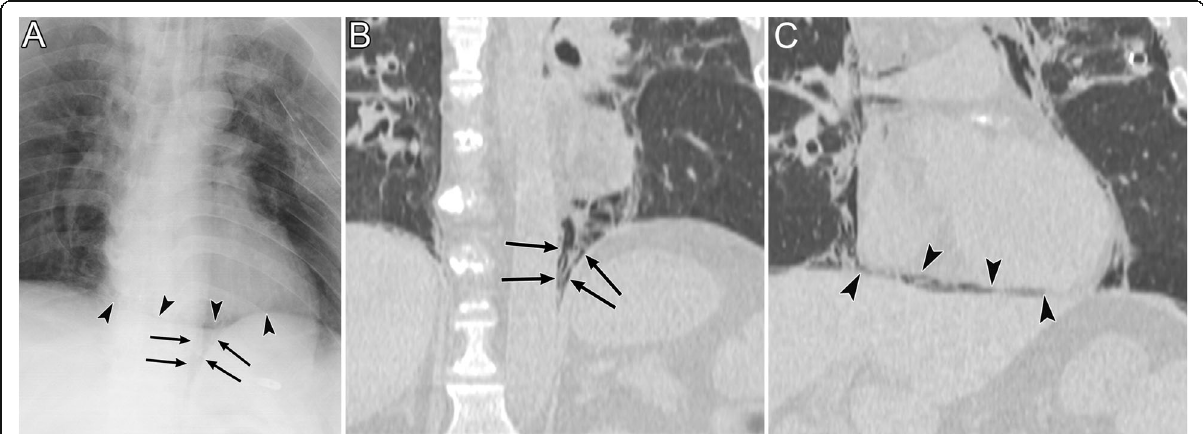
Fig. 16 Pneumomediastinum in a 50-year-old man. The pneumomediastinum was caused by tracheostomy displacement. a A supine radiograph shows pneumomediastinum and subcutaneous emphysema. Air along the left aortic border and the medial left hemidiaphragm become V- shaped (i.e., “ Naclerio ’ s V ” sign) (arrows). The “ continuous diaphragm ” sign (arrowheads) is also visible. b A coronal CT image of the lung base reveals “ Naclerio ’ s V ” sign (arrows). c Another coronal CT image of the lung base reveals a “ continuous diaphragm ” sign (arrowheads)